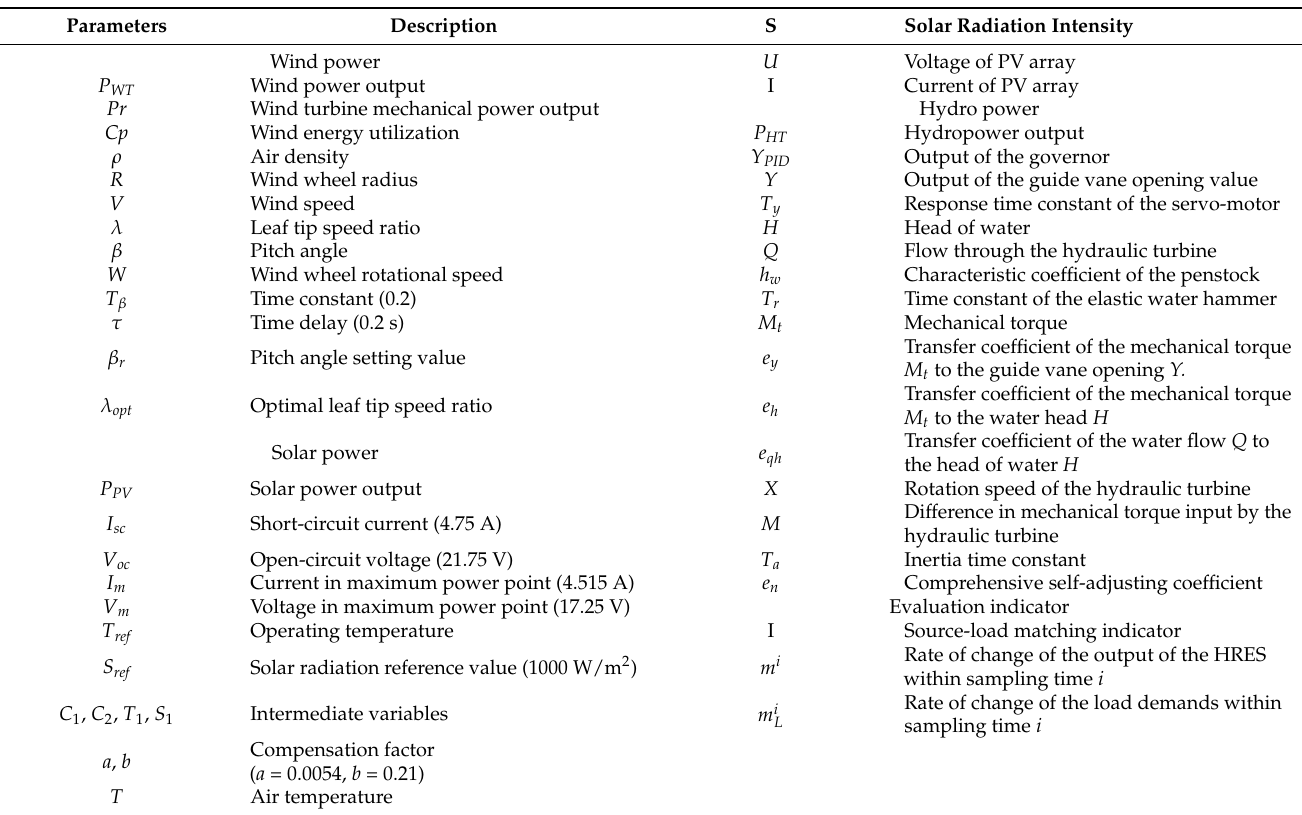
Figure 1. Sand-table deduction methodology. The HRES sand-table model-related parameters are listed in Table 1. Table 1. Sand-table model-related parameters.